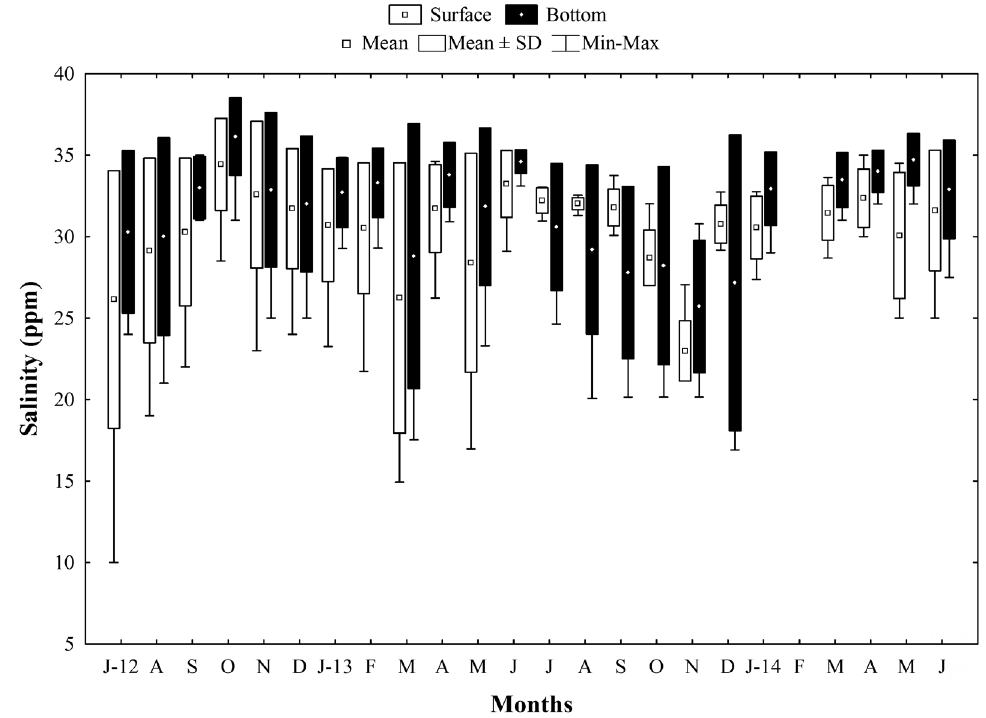
Figure 4. Temporal variation of salinity values of bottom and surface water, from July/2012 to June/2014, in Cananéia region, Brazil. (Mean; SD = standard deviation; Min = minimum; Max =